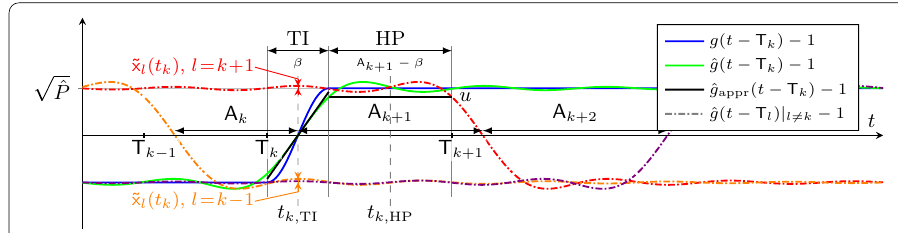
Fig. 3 ISI model: original g ( t − T k ) − 1 , filtered ˆ g ( t − T k ) − 1 , and interfering pulses ˆ g ( t − T l ) − 1 | l �= k . The ISI at a time t k is the superposition of the contribution of all pulses ˆ g ( t − T l ) − 1 , where l = k